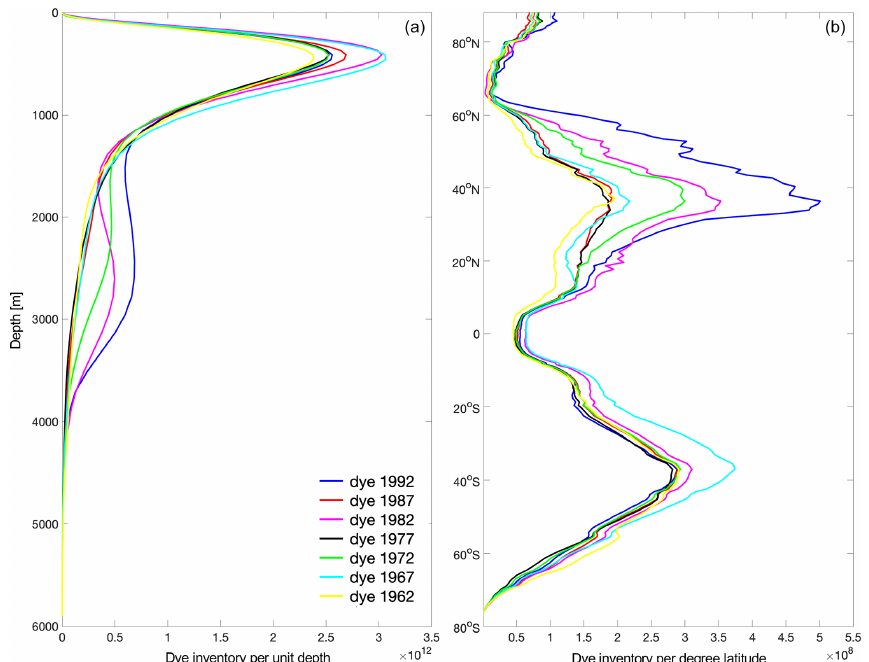
Figure 11. Global tracer concentration 25 years after injection for seven different vintages as a function of depth (a) and latitude (b)